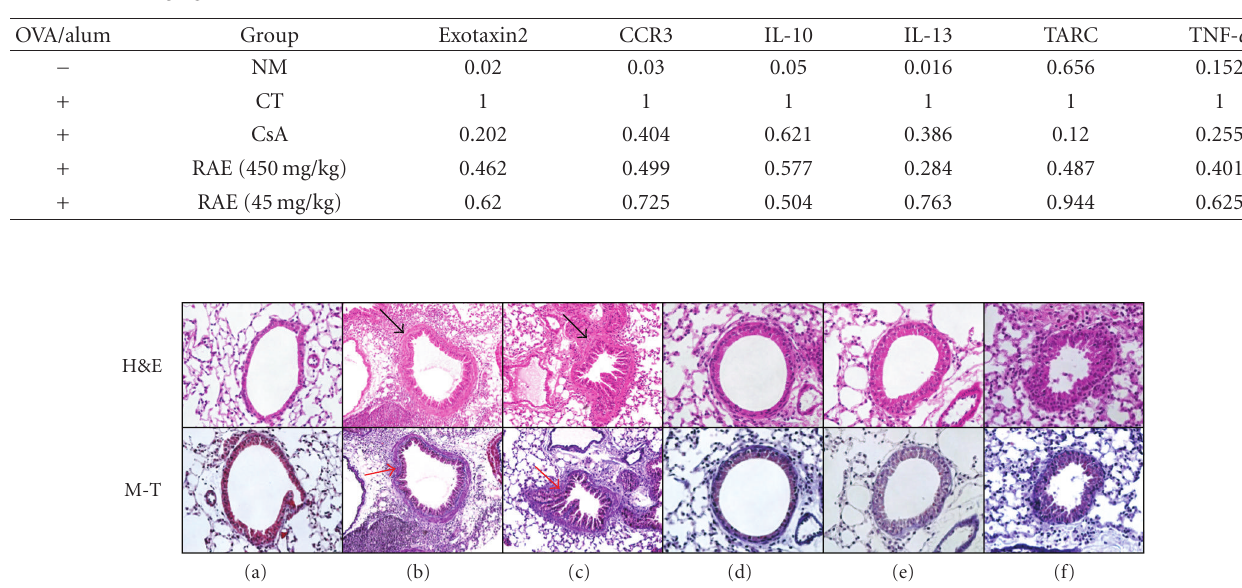
Table 3: E ff ect of RAE on Eotaxin2, CCR3, IL-13, IL-10, TNF- α , and TARC mRNA expression in lung tissue of OVA-induced murine model of asthma (NM: normal C57BL/6 mice; CT: OVA-induced asthma mice (control); CsA: OVA-induced asthma mice treated with cyclosporine A (10mg/kg); RAE 45 mg/kg: OVA-induced asthma mice treated with RAE (450mg/kg); RAE 450 mg/kg: OVA-induced asthma mice treated with RAE (450mg/kg)).